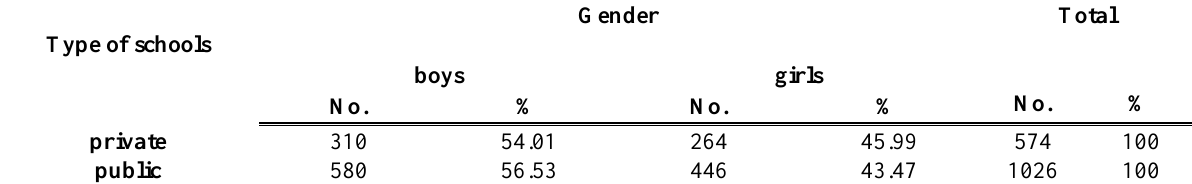
Table (1): Distribution of t he sample by gender and school type.